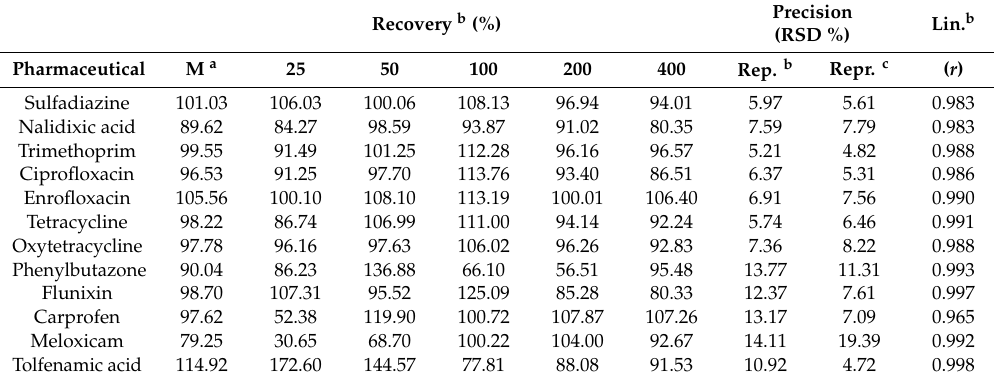
Table 3. Accuracy, precision and linearity of the pharmaceuticals from spiked hen plasma samples.